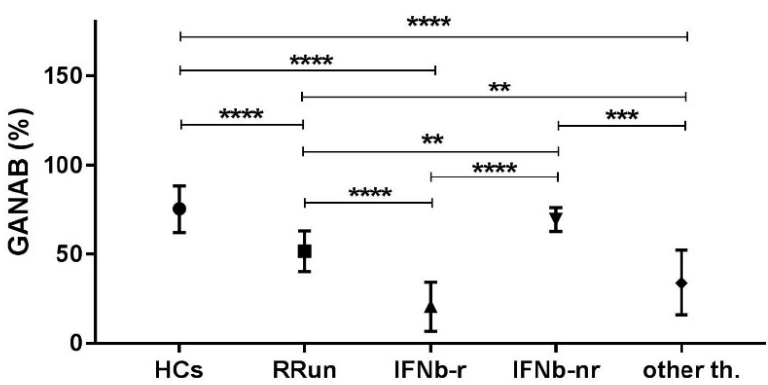
Figure 5. Comparison of the mean expression of GANAB (%) in each group considered in the study. Table 2. Relative ratios values and p values of the compared study groups. HCs, healthy controls; RRun, relapsing remitting untreated MS patients; IFNb-r, responder MS patients to IFNbeta-1a therapies; IFNb-nr, non-responder MS patients to IFNbeta-1a therapies; other th., MS patients treated with other than interferon therapies. Symbol meaning: ↑ = upregulation, n.s. = p > 0.05.